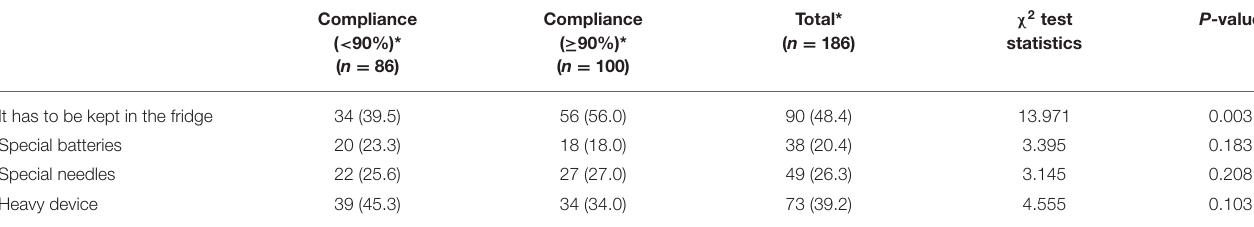
TABLE 5 | Comparison between compliance groups for the most inconvenient feature of the